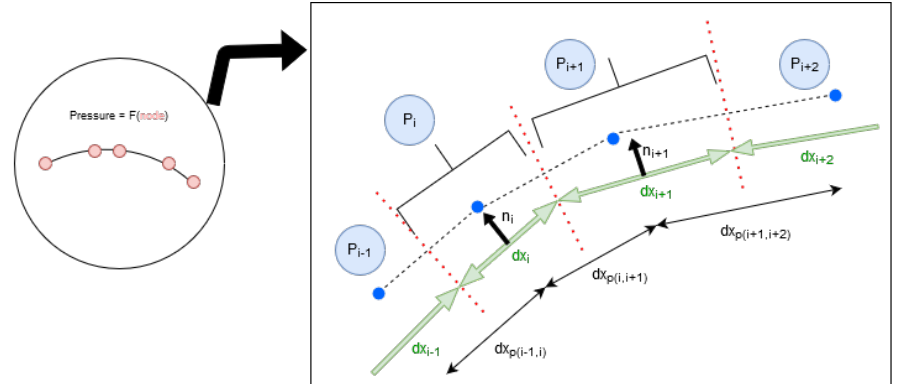
Figure 9. Methodology used to apply concentrated loads from discrete pressure values.